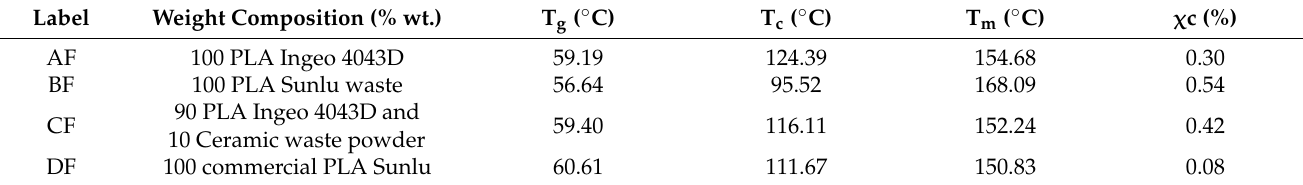
Table 3. Thermal properties of filaments and percentage of crystallinity χ c (%).